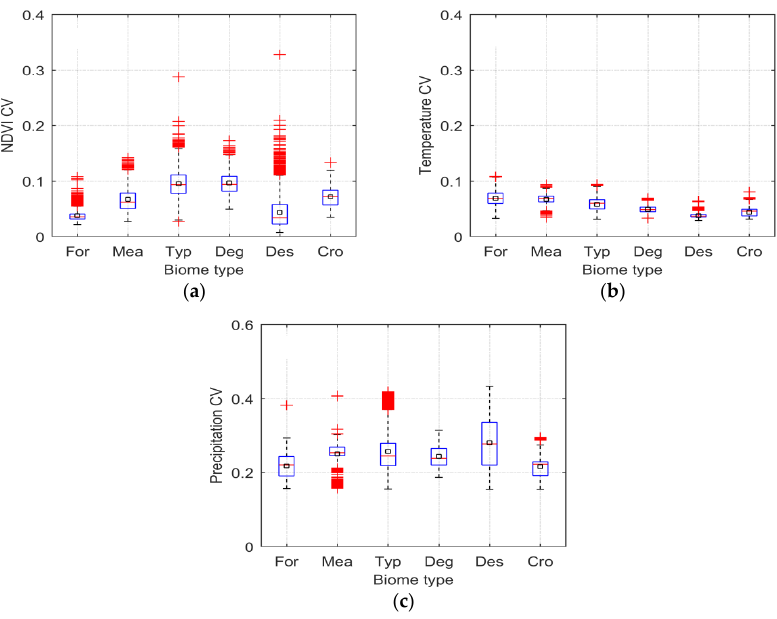
Figure 3. Mean CV of the growing season NDVI ( a ), temperature ( b ), and precipitation ( c ) for forest (For), meadow steppe (Mea), typical steppe (Typ), desert steppe (Deg), desert (Des), and crop (Cro) in Inner Mongolia during 1982–2015. The bottom and top edges of each blue box represent the 25th and 75th percentiles, respectively. The horizontal red line in each blue box indicates the median values. The open black square in each blue box means mean values. The black whiskers extend to the 1.5 times the interquartile range. Red crosses represent